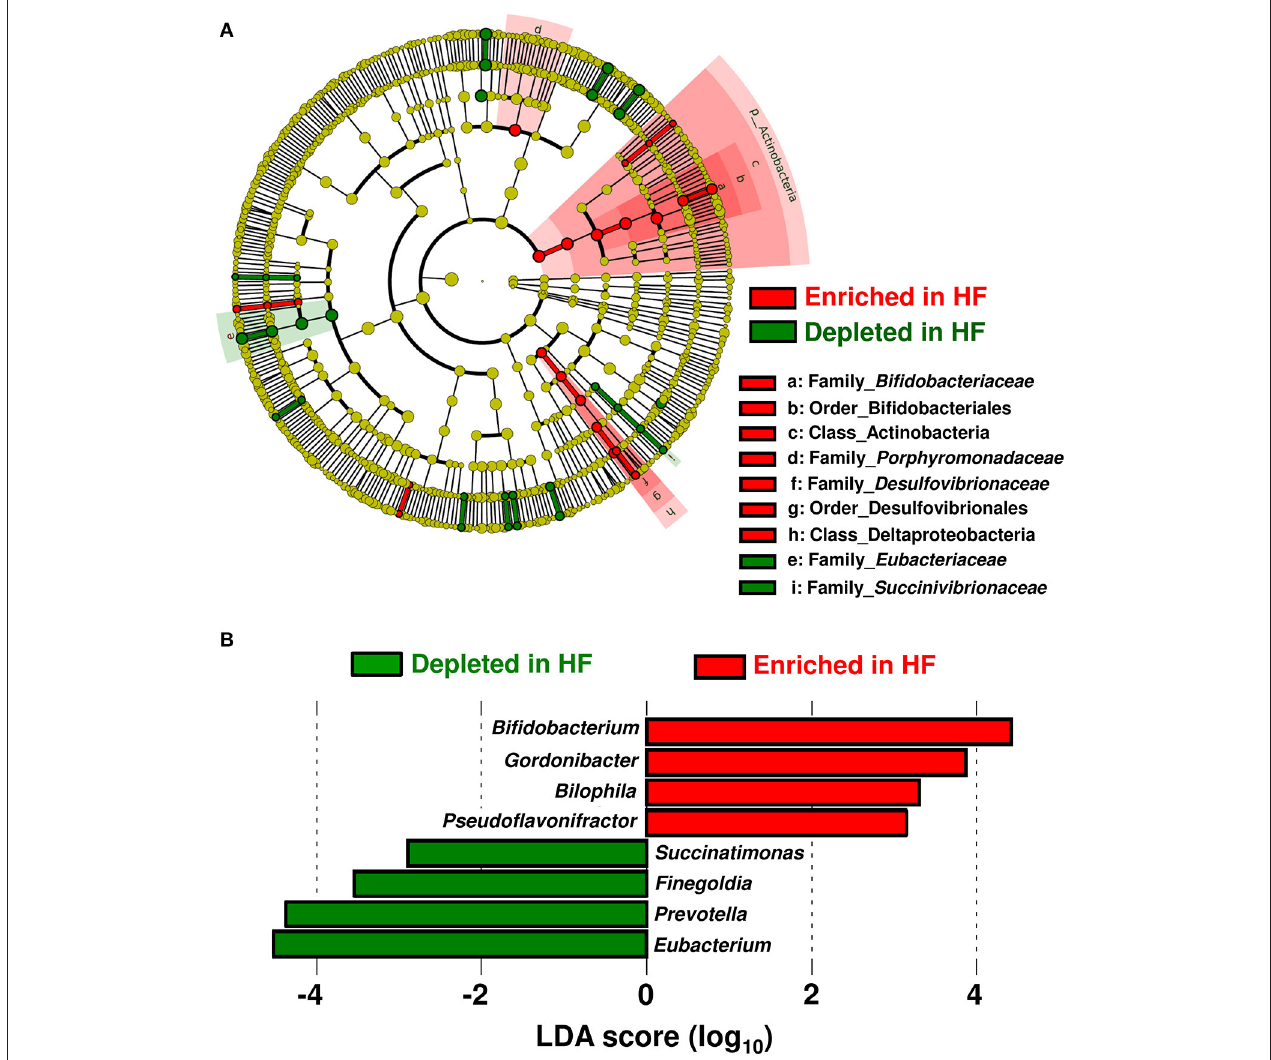
FIGURE 1 | Compositional differences in gut microbiota between heart failure (HF) patients ( n taxa at the class, order, and family levels between patients with HF and controls. Only the taxa with P < 0.05 and a linear discriminant analysis (LDA) significant threshold of > 2.0 are shown. (B) Taxa at the genus level. The enriched taxa in patients with HF and controls are presented as positive (red) and negative (green) LDA scores, respectively.